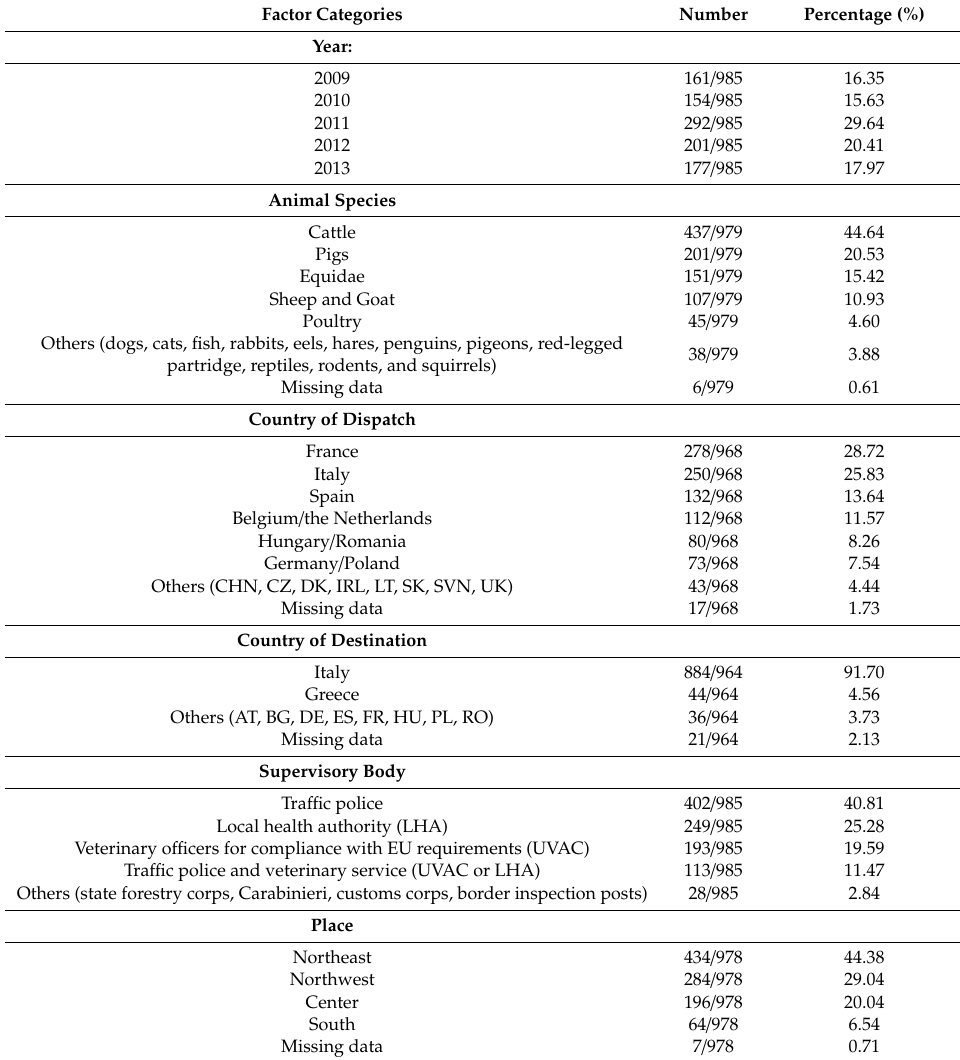
Table3. Descriptivestatisticsoftheinfringementsthatwereuncoveredduringliveanimaltransportation as recorded in the Italian Health Ministry reports on the infringements that were written in compliance with Article 27 of EC 1 / 2005 from 2009 to 2013. The number of vehicles that were found not to be complying with one or more articles of EC 1 / 2005 according to year, species, the country of dispatch, the country of destination, supervisory body, and the place of inspection.